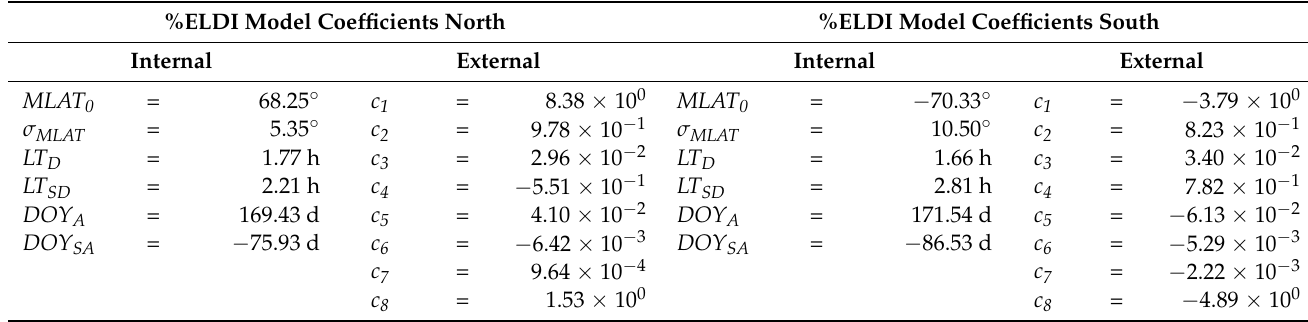
Table 6. Coefficients of the ELDI occurrence probability (%ELDI) model for the Northern and Southern Hemispheres. %ELDI Model Coefficients